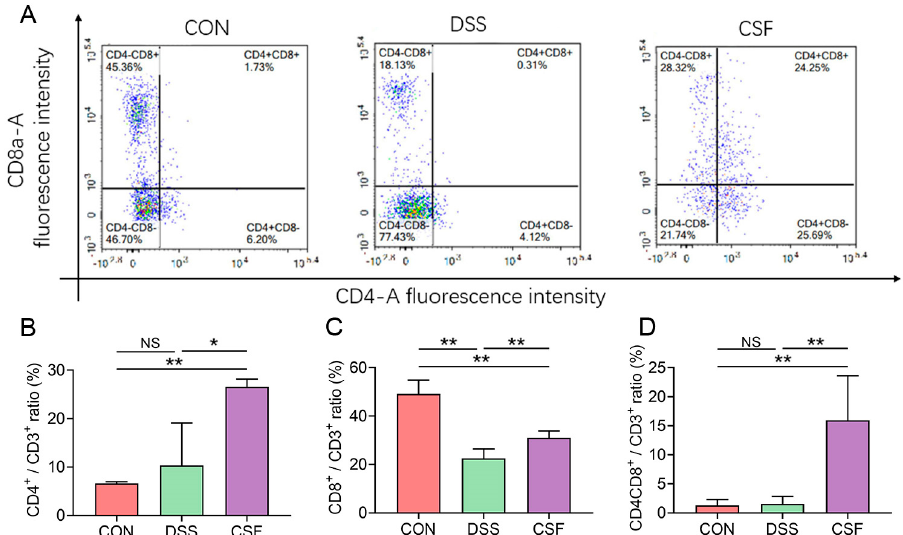
Figure 6. CSF altered the T-lymphocyte subsets in the colon tissue of the colitis mice ( n = 5). ( A ) The flow cytometry results of T-lymphocyte subsets of the representative mouse. ( B – D ) The bar graph of the results. The data are presented as mean ± SD, * p < 0.05, ** p < 0.01, NS: no significance.